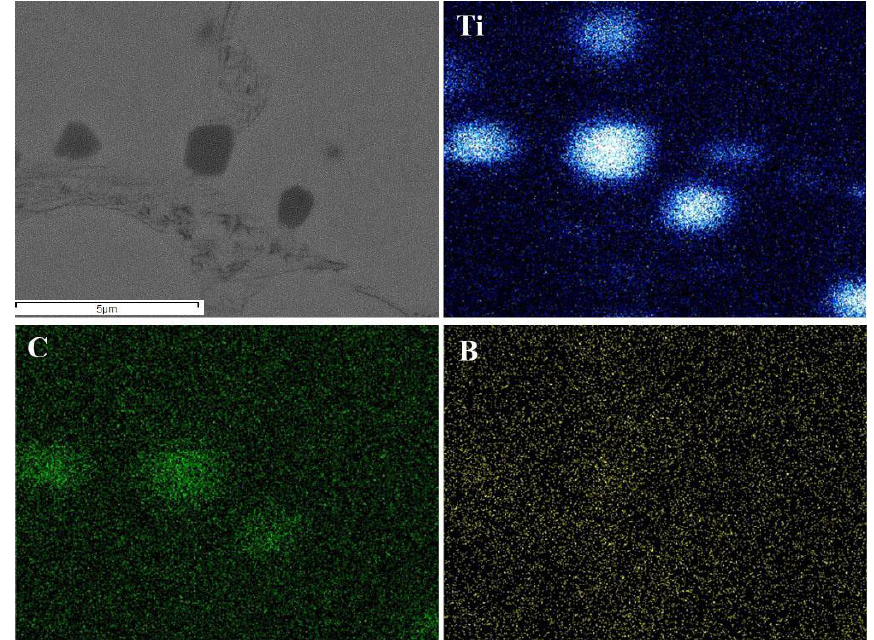
Figure 12. Elemental distributions of irregular cubic blocks in Figure 8b.